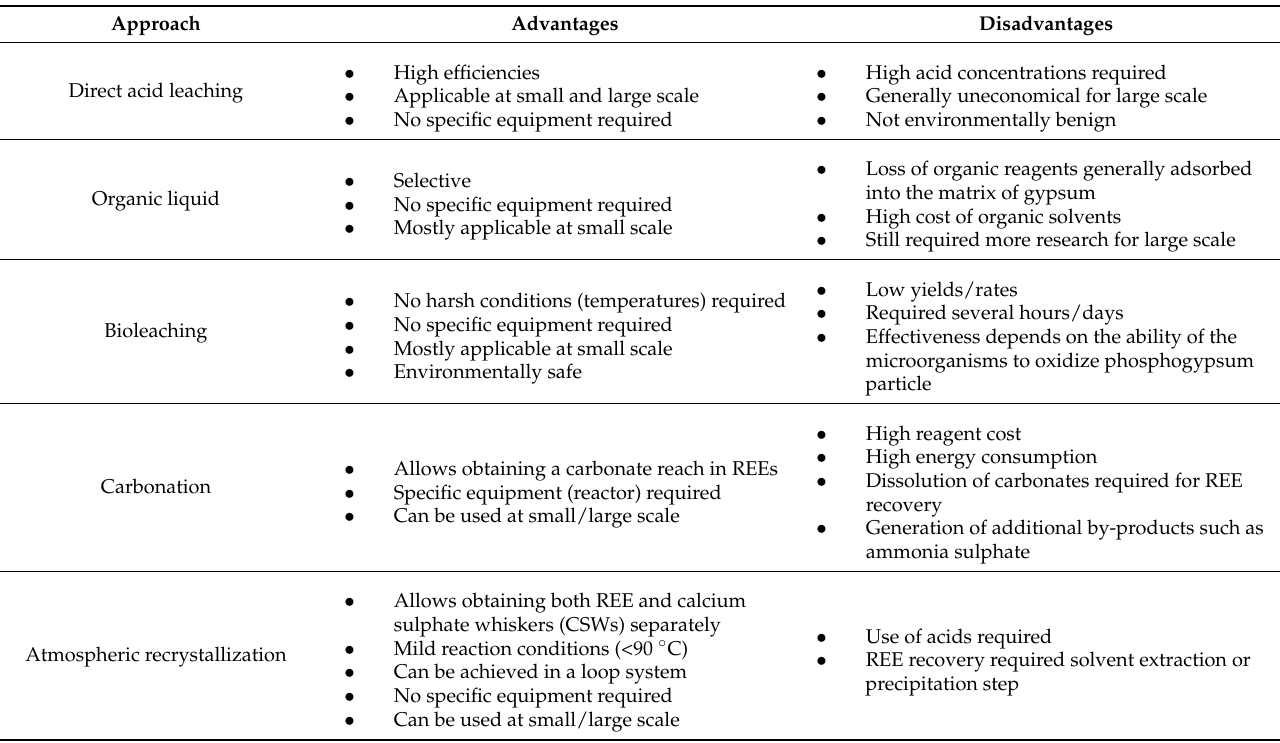
Table 4. Overview of the advantages and disadvantages of the approaches discussed in this review.